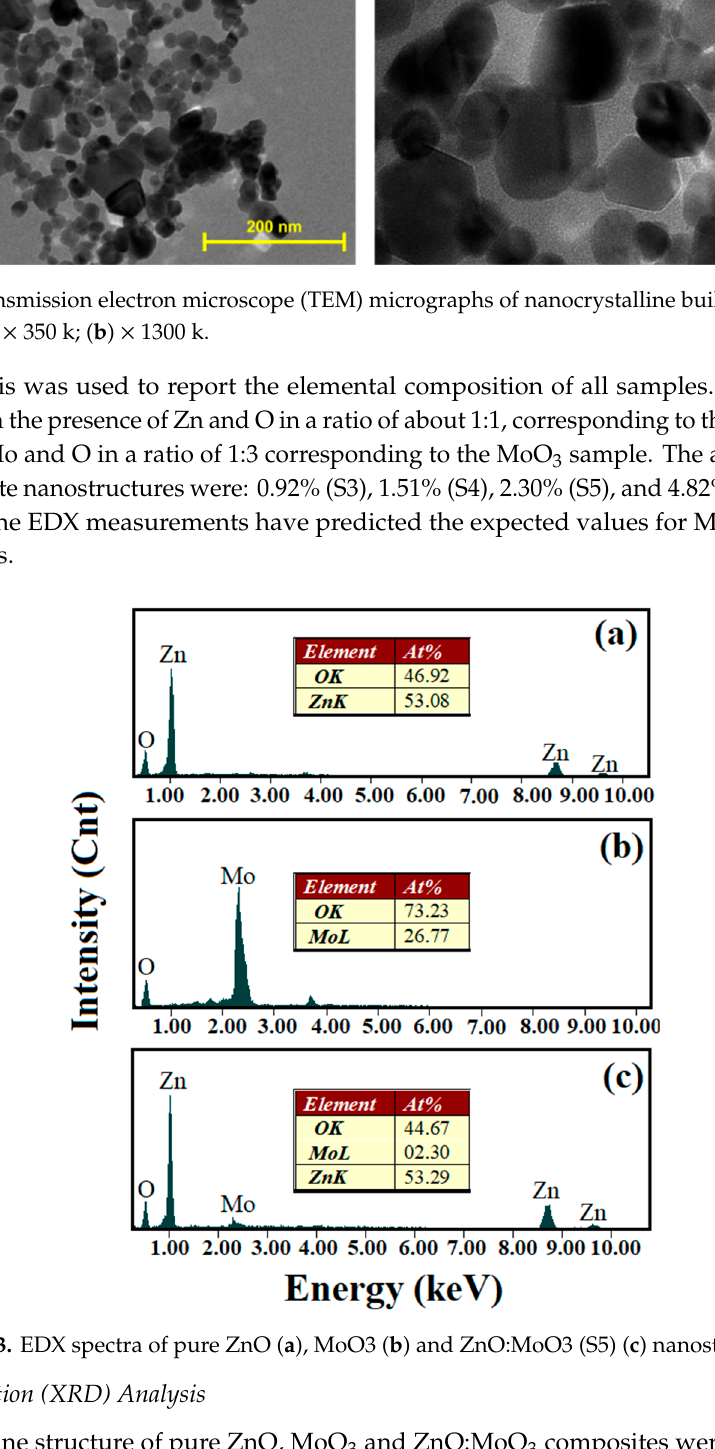
Figure 1. Scanning electron microscope (SEM) images of the ZnO (S1) ( a ), MoO 3 (S2) ( b ), ZnO:MoO 3